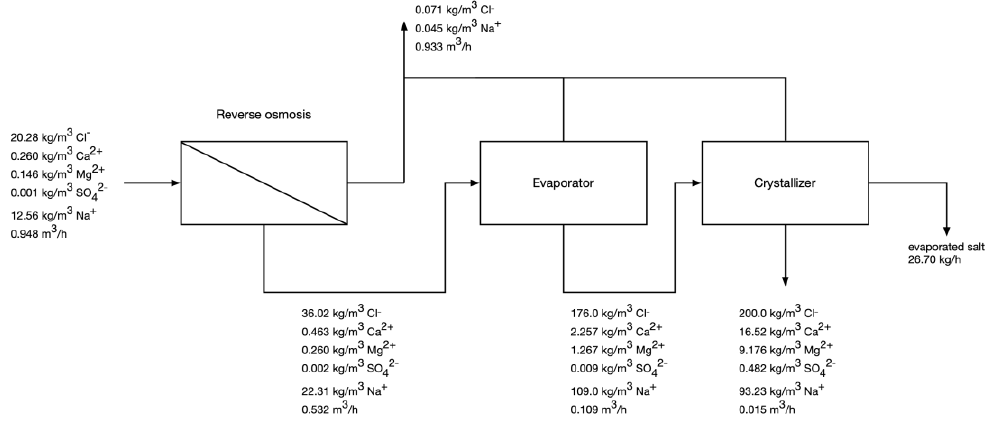
Figure 4. Calculated compositions of process streams in RO-evaporator-crystallizer if NF pretreat- ment is used.